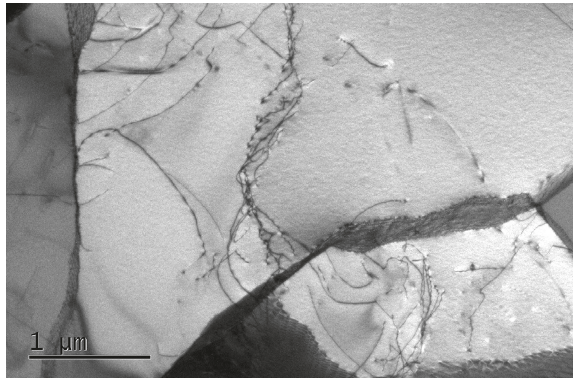
Figure 10: TEM microstructure of 18Mn18Cr0.6N steel com- pressed at 1050 ° C and 10 − 4 · s − 1 to 0.2.